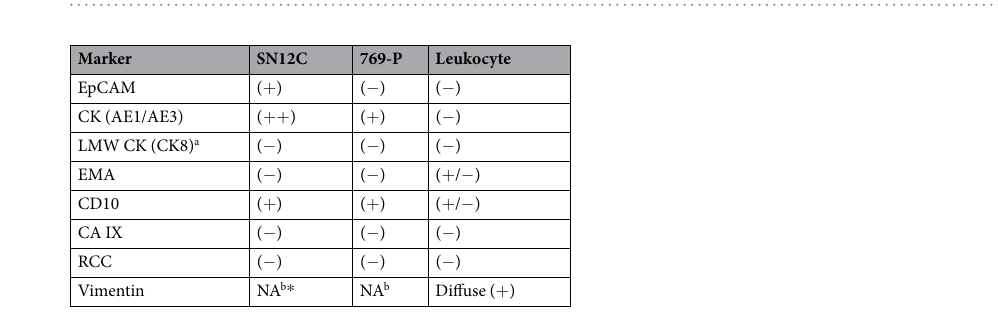
Table 1. Immunocytochemical stain in lung and ovarian cancer cell line cell block. * Positive rate in cancer cells. ( + ) focal or partial expression. ( ++ ) diffuse expression.